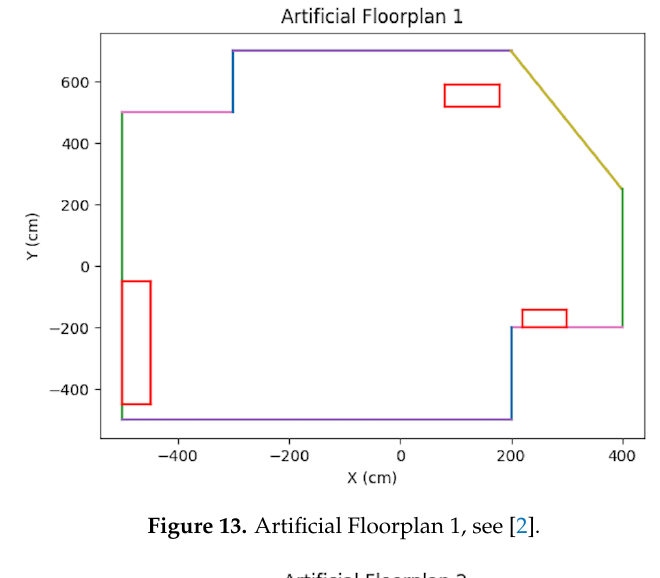
Figure 13. Artificial Floorplan 1, see [2].